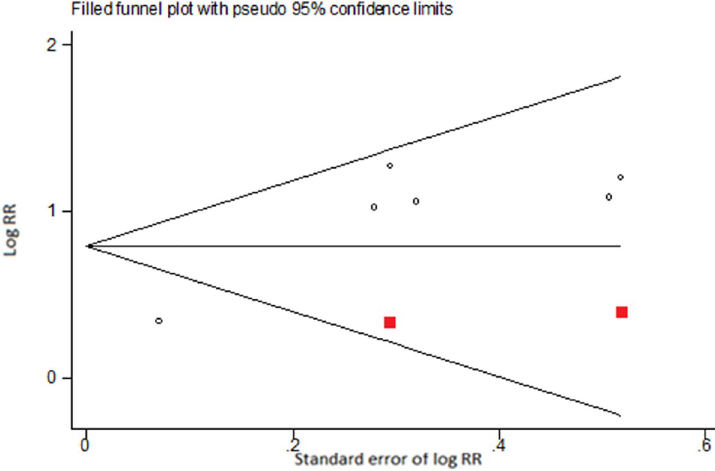
Fig 9. Funnel plot illustrating results from trim-and-fill analysis of adjusted log RRs for outcome ever e-cigarette use at baseline and current cigarette use at follow-up.